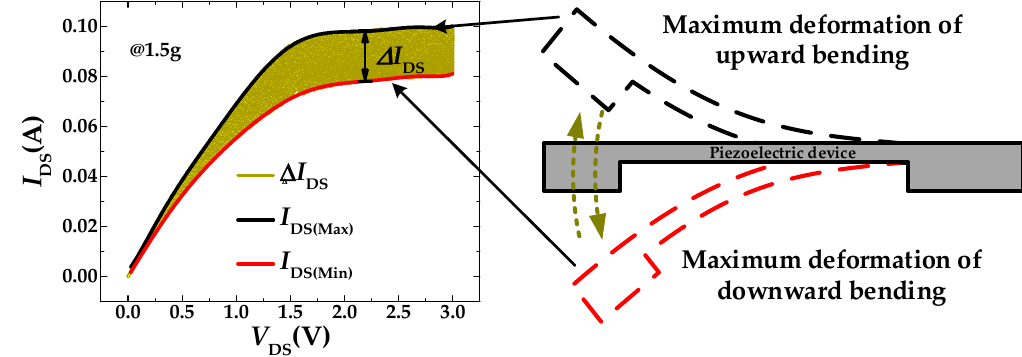
Figure 9. I DS -V DS characteristics curves of the MOSFET with the piezoelectric beam.